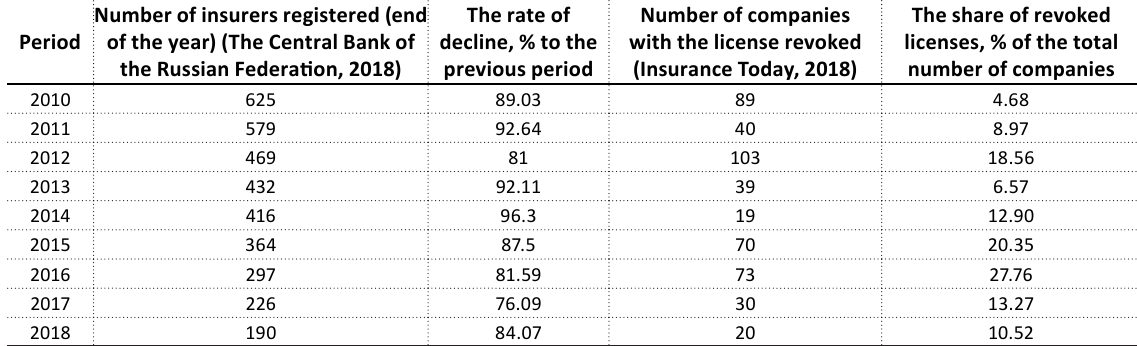
Table 2. Dynamics of the number of insurers registered in the Russian Federation for the 2010–2018